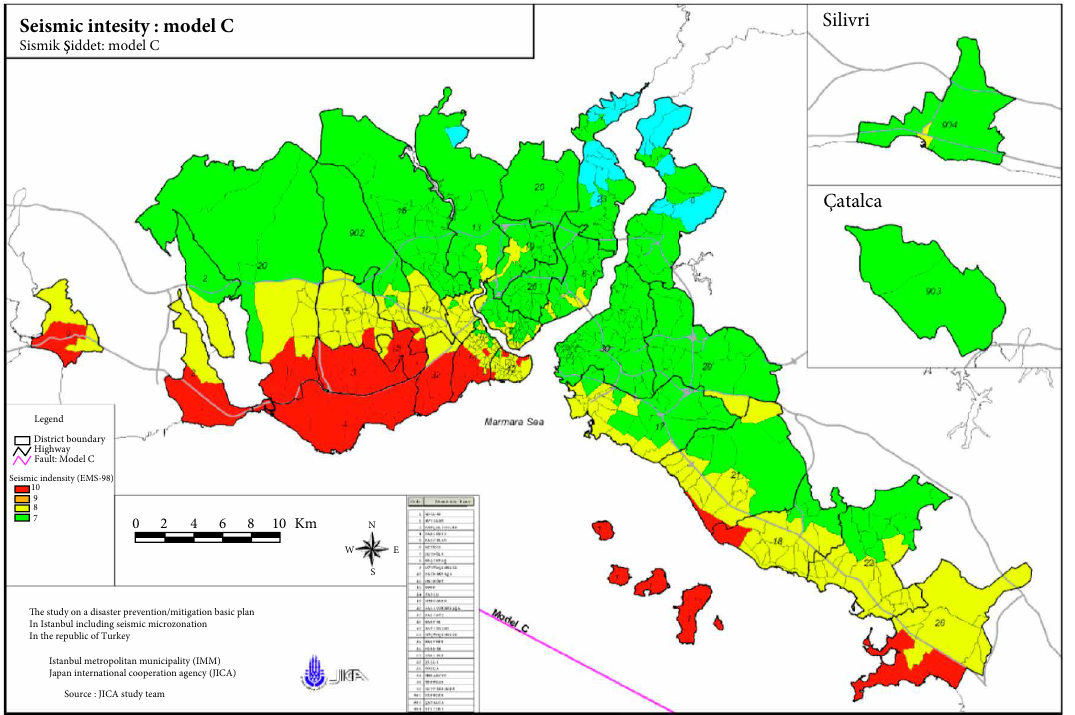
Figure 4: Seismic intensity in model C